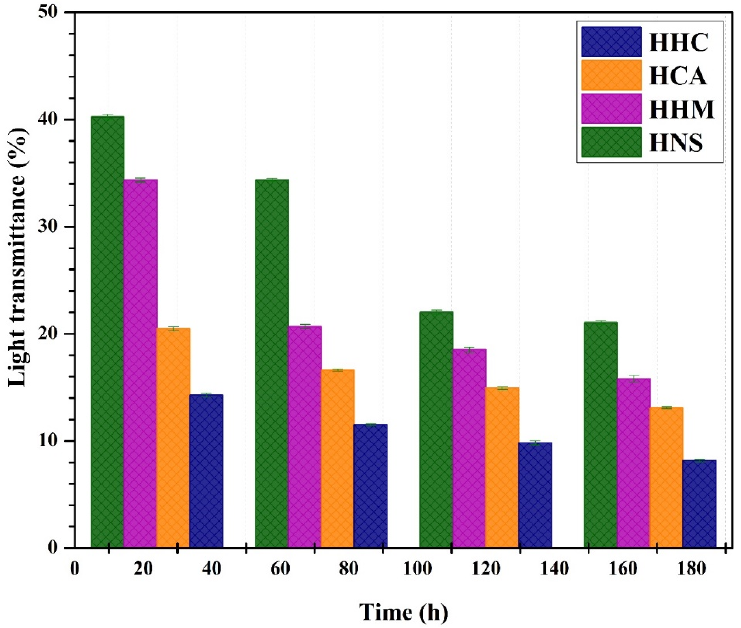
Figure 4. Light transmittance of native and modified Hausa potato starch.